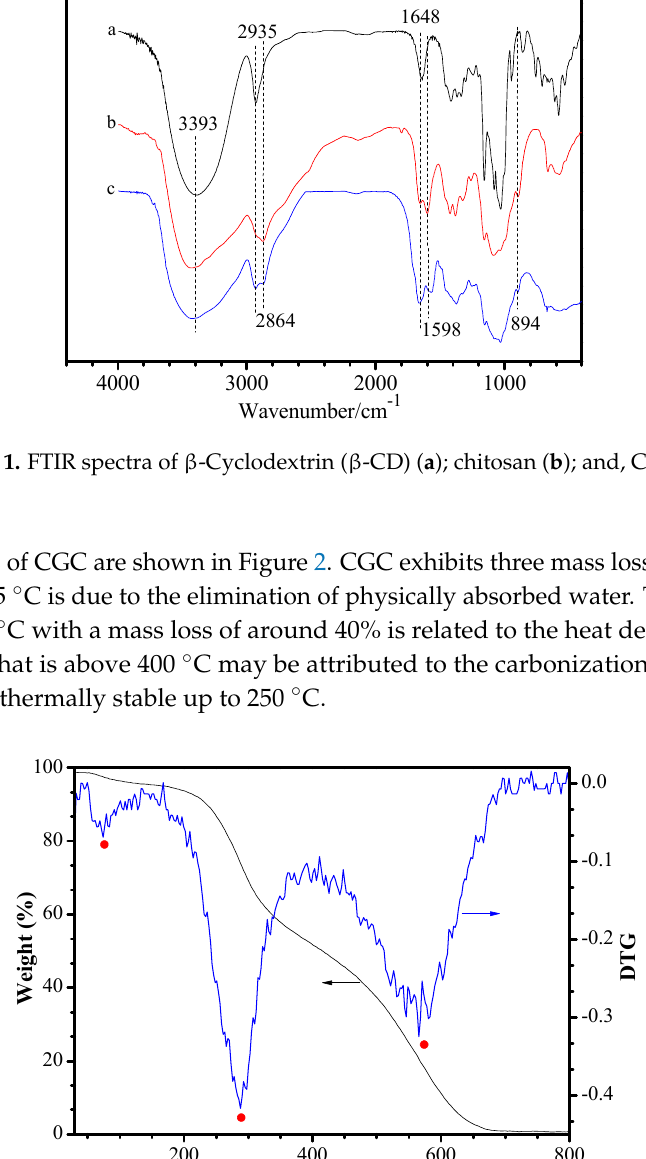
Figure 2. TG and DTG curves of CGC.